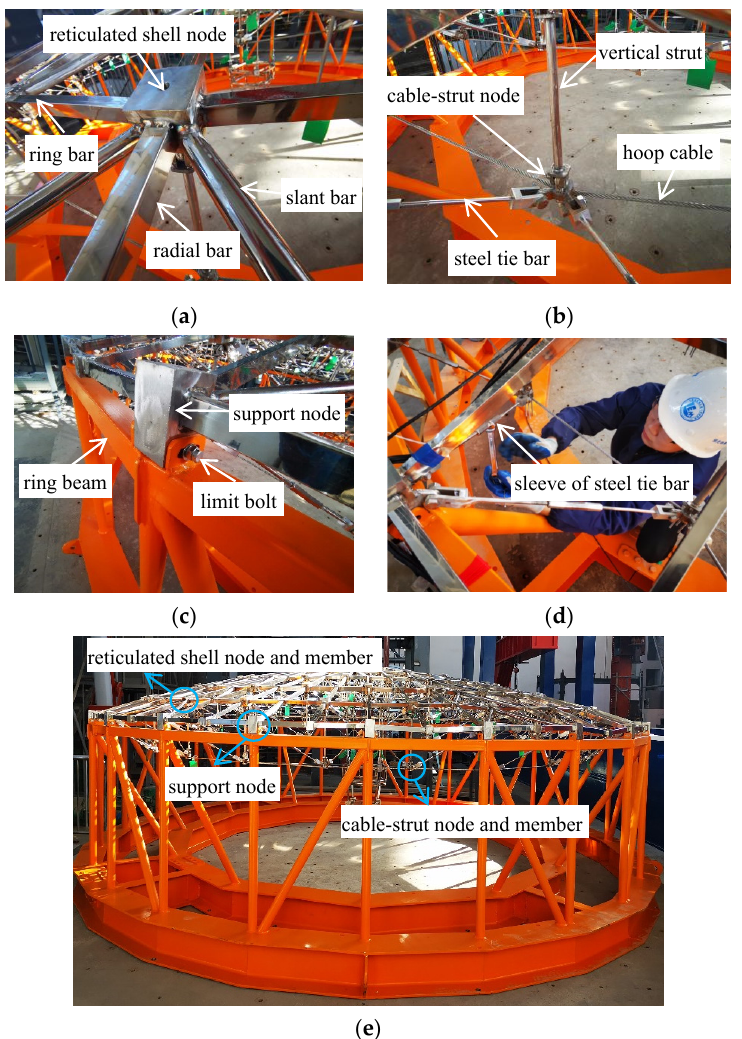
Figure 5. Nodes and Members: ( a ) Reticulated shell node and member; ( b ) Cable-strut node and member; ( c ) Support node; ( d ) Applying preload; ( e ) Overall model. The bars of the center-hung scoreboard are made of the same material as the reticulated shell members, which are connected to the hanging platform in the center of the reticulated shell by four slings. In order to simulate the actual weight of the scoreboard in the prototype structure, mass blocks were placed inside the scoreboard in the test model, as shown in Figure 6, and the total weight of the center-hung scoreboard and mass blocks of the scale model is 0.5 kN.